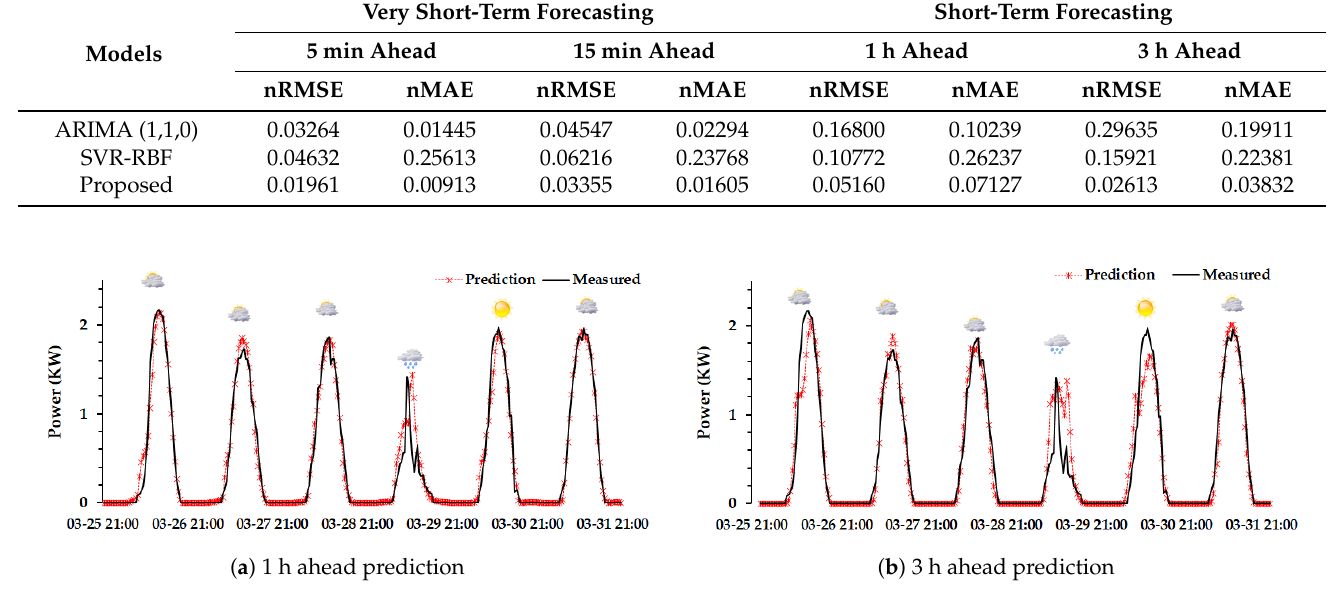
Figure 15. The short-term forecast results of PV power generation for 6 consecutive days (RNN layers = 3, time steps = 12, sampling interval = 30